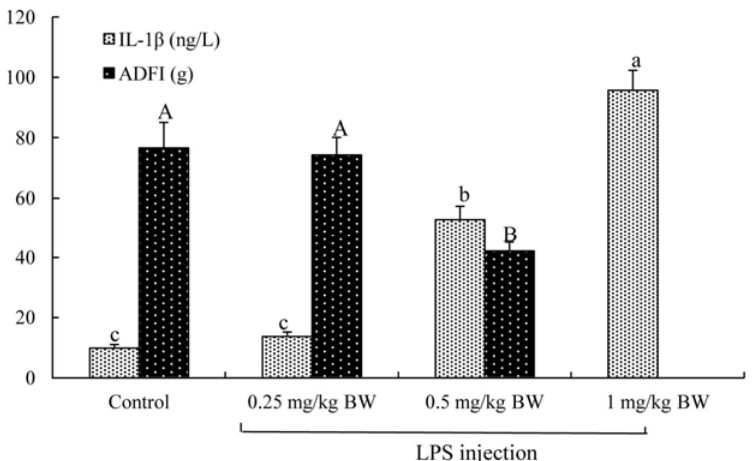
Figure 1. Preliminary study to determine the dose of lipopolysaccharide (LPS) used in inducing broilers immune stress. Twenty four 22- day-old male Cobb broilers were randomly assigned to four groups (control, 0.25 mg/kg body weight [BW] LPS, 0.5 mg/kg BW LPS, and 1 mg/kg BW LPS). At the age of 22, broilers in the 0.25 mg/kg BW LPS, 0.5 mg/kg BW LPS, and 1 mg/kg BW LPS groups were intraperitoneally injected with LPS at the dose of 0.25, 0.5, and 1 mg/kg BW, respectively, whereas those in the control groups were intraperitoneally injected with saline at the dose of 0.25 mg/kg BW. Blood samples were taken from a wing vein puncture at 24 h post LPS or saline injection and serum interleukin-1 β (IL-1 β ) levels were determined. The feed intake was recorded from the ages of 22 to 28. Data were expressed as mean values with standard error of mean (n = 6). a,b,c Means with different superscripts in IL-1 β levels differ significantly (p<0.05). A,B Means with different superscripts in average daily feed intake (ADFI) differ significantly